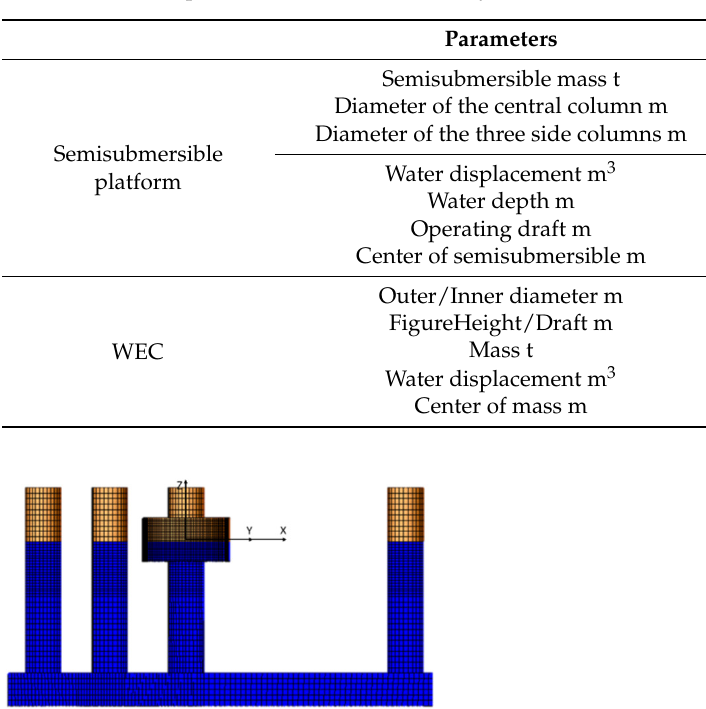
Table 2. The main parameters of the combined system.